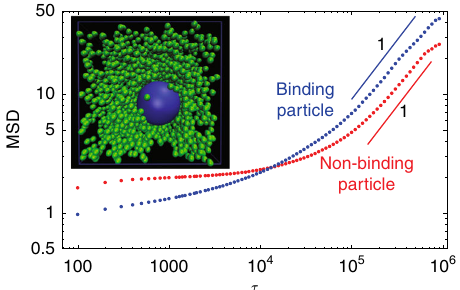
Fig. 6 Enhanced diffusion in a three-dimensional reversible gel with moderate binding af fi nities. The mean squared displacement of a binding particle (blue) and a non-binding particle (red) shows the same general features as in two dimensions (Fig. 5c). Inset: snapshot of the diffusing particle and the